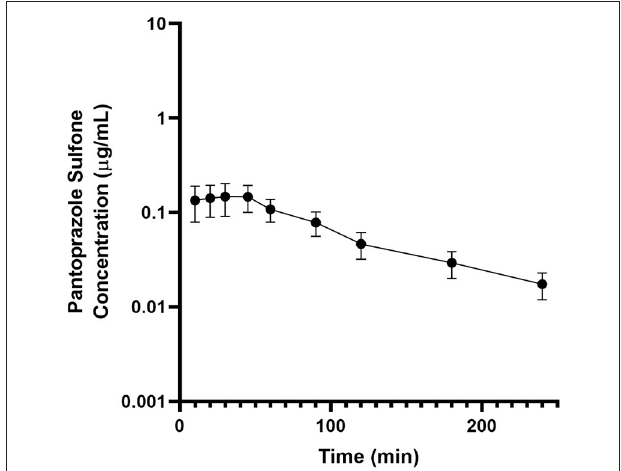
FIGURE 2 | Mean plasma pantoprazole sulfone concentration (logarithmic scale) vs. time (hr) profiles for adult goats ( n = 6) following intravenous (IV) single dose administration of 1.0 mg/kg of pantoprazole. Mean is represented by a black circle with error